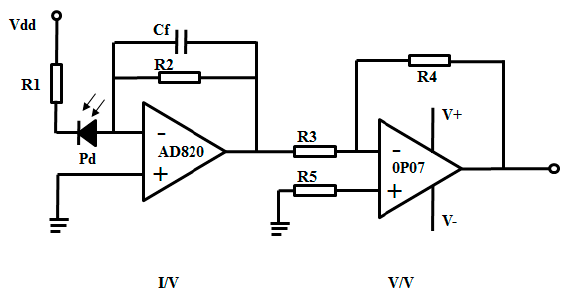
Figure 9. A structure diagram of the I/V conversion circuit and V/V amplification circuit.